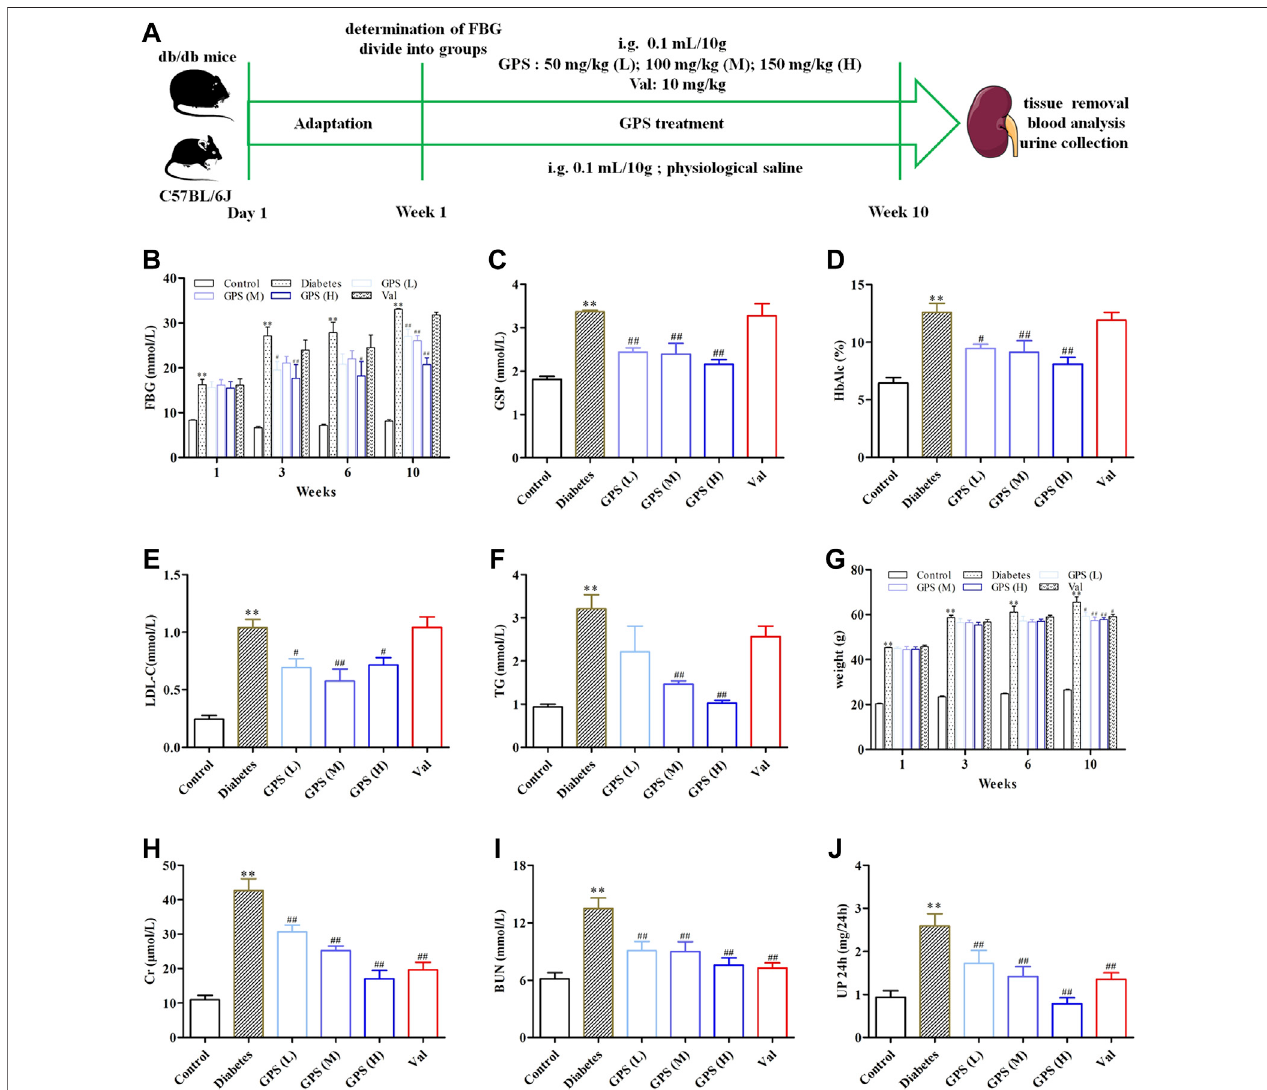
FIGURE 1 | Effects of GPS on blood and urine biochemical parameters of diabetic mice. (A) Process of the experiment in vivo . (B – D) Levels of FBG, GSP, and HbAlcofexperimentalanimals. (E,F) LevelsofLDL-CandTGofexperimentalanimals. (G) Bodyweightofexperimentalanimals. (H – J) LevelsofCr,BUN,and24 hUpof experimental animals. Data were expressed as means ± SD. n = 8. Diabetes: diabetes group; GPS (L): GPS treatment group (low dose: 50 mg/kg); GPS (M): GPS treatmentgroup(mediumdose:100 mg/kg);GPS (H) :GPStreatmentgroup(highdose:200 mg/kg);Val:valsartantreatmentgroup(10 mg/kg).** p < 0.01 vs .Ctrl. ## p < 0.01 and # p < 0.05 vs .